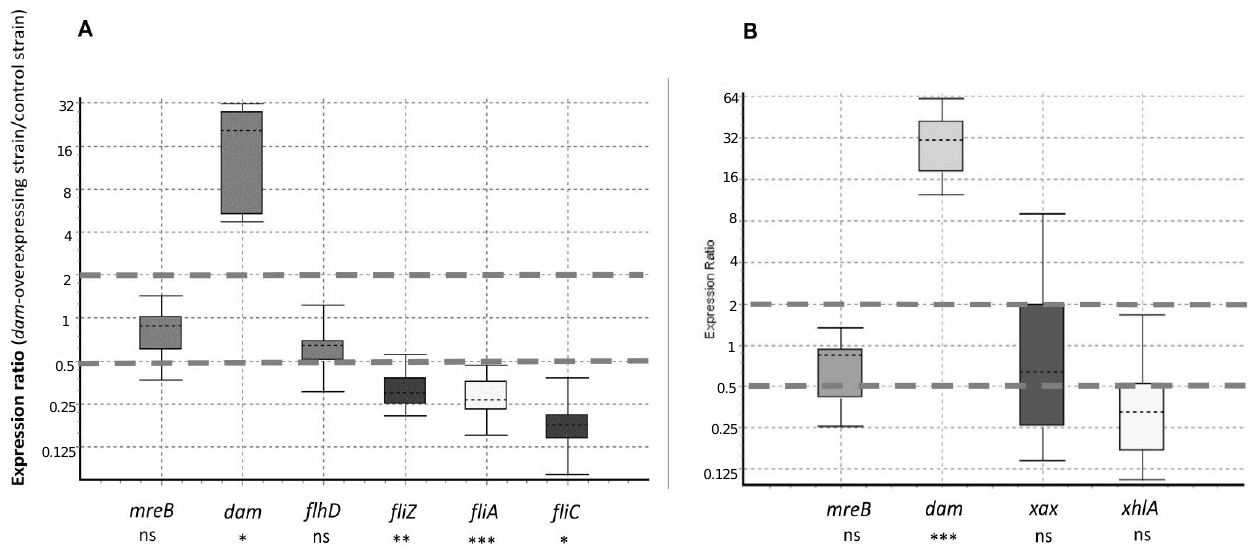
Figure 9. Relative expression of 9 selected genes in the X. nematophila dam -overexpressing strain. qRT-PCR was carried out with total RNA extracted from cells of the dam -overexpressing strain and of the control strain harvested during exponential ( A ) or stationary ( B ) phase of growth. Box plot representing the expression ratio between the two strains is shown for each tested gene, with recA used as a reference gene (see Materials and Methods section for details). Results are from 3 independent cultures for each strain. Expression ratios between 0.5 and 2 are flanked by dotted gray lines. The level of expression between the 2 strains was different at p < 0.05 (*), at p < 0.01 (**), at p < 0.001 (***), or was not significantly different (ns, p > 0.05), depending on the tested